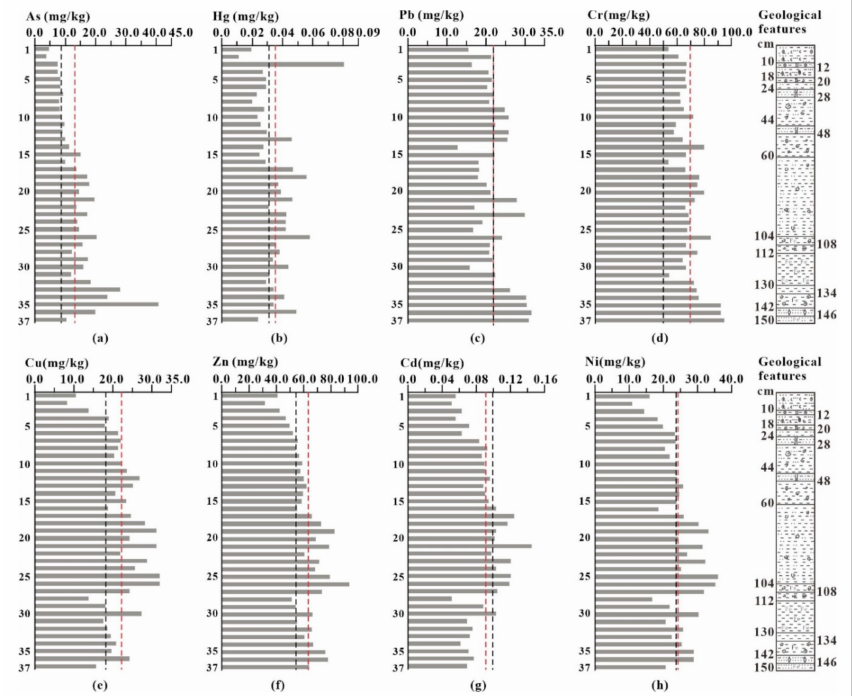
Figure 4. Concentration profiles of heavy metals in the sediment core from the Chagan Lake. ( a ) As, ( b ) Hg, ( c ) Pb, ( d ) Cr, ( e ) Cu, ( f ) Zn, ( g ) Cd and ( h ) Ni. (Black dash line-background value; Red dash line-mean